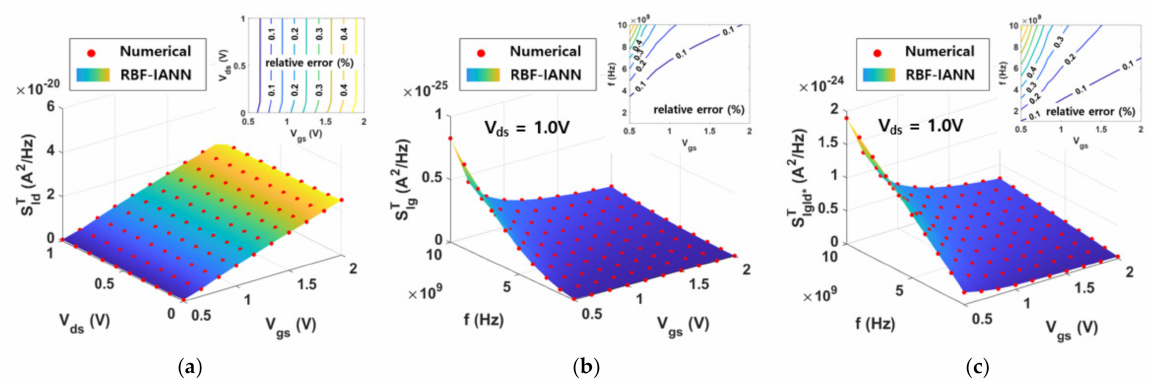
Figure 7. Comparison of numerical data with results obtained using the RBF-IANN model for ( a ) the thermal drain current noise, ( b ) the induced gate current noise, and ( c ) the drain-gate correlation noise.